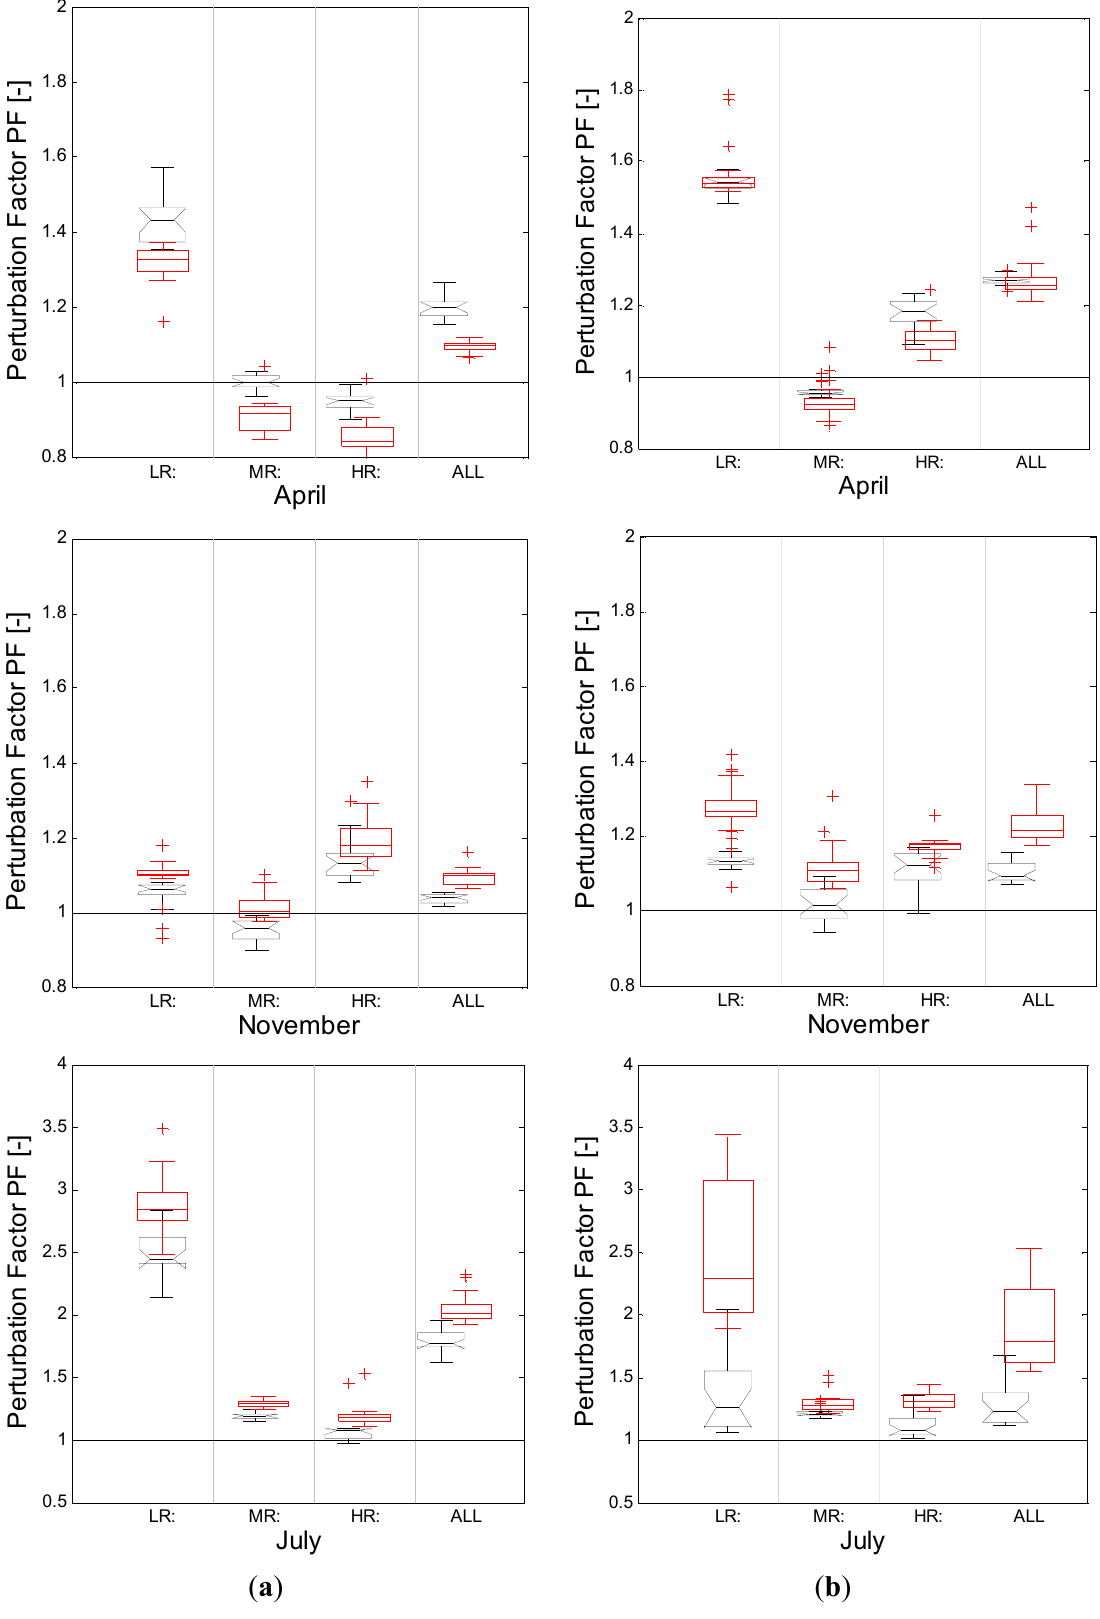
Figure 15. Perturbation factors for daily precipitation simulated by GCMs in the months of April, November and July for the 2040s (notched) and 2075s, including outliers represented by (+) ( a ) RCP4.5; ( b )